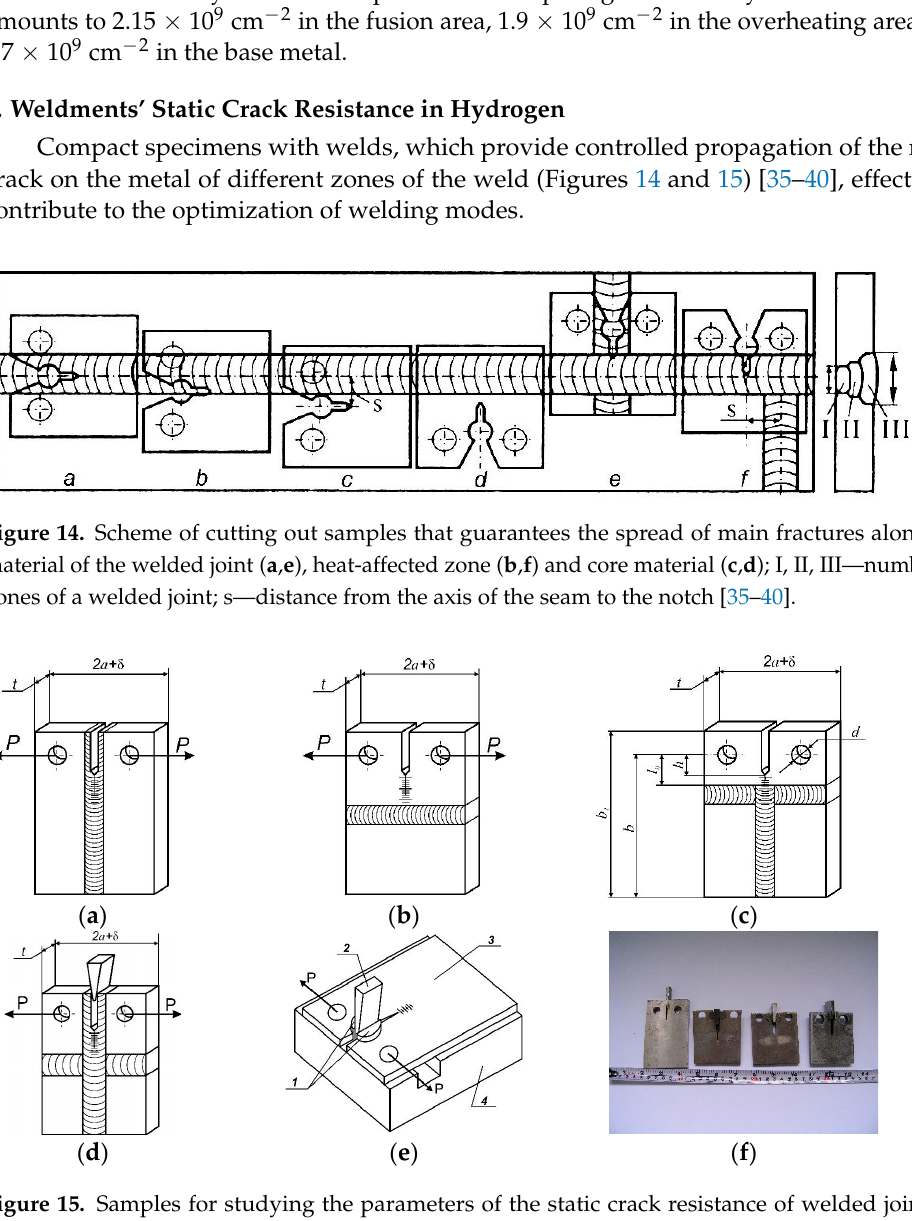
( c ) Figure 16. Cracked specimens over the cross-section of the WJ template with a roof and different configurations ( a , b ), which, during crack propagation, can serve as traps for cracks and change their trajectory. Example of uncontrolled deviation of the crack propagation direction at the angle up to 90° ( c ). Uneven grain sizes, the sizes and distribution of reinforcing phases, local thermal stresses and other defects cause the significant sensitivity of various structural elements of welded joints to the action of hydrogen [41–46]. Even the simulation of the soldering regime with the short-term (15 min) heating of KhN43MBTYu and 05Cr19Ni55 alloys to 1473 K leads to an increase in grain size and the concentration of large grain boundary